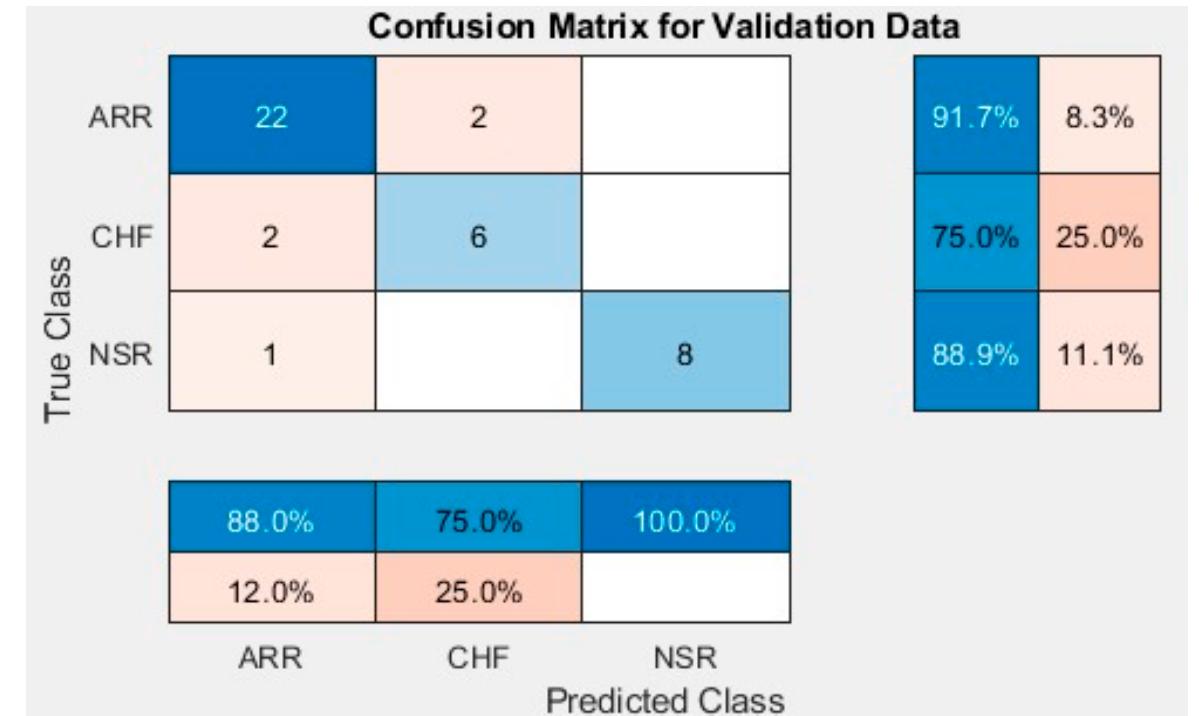
Figure 13. Confusion matrix for the training set of the proposed hybrid BA-CNN-LSTM algorithm.